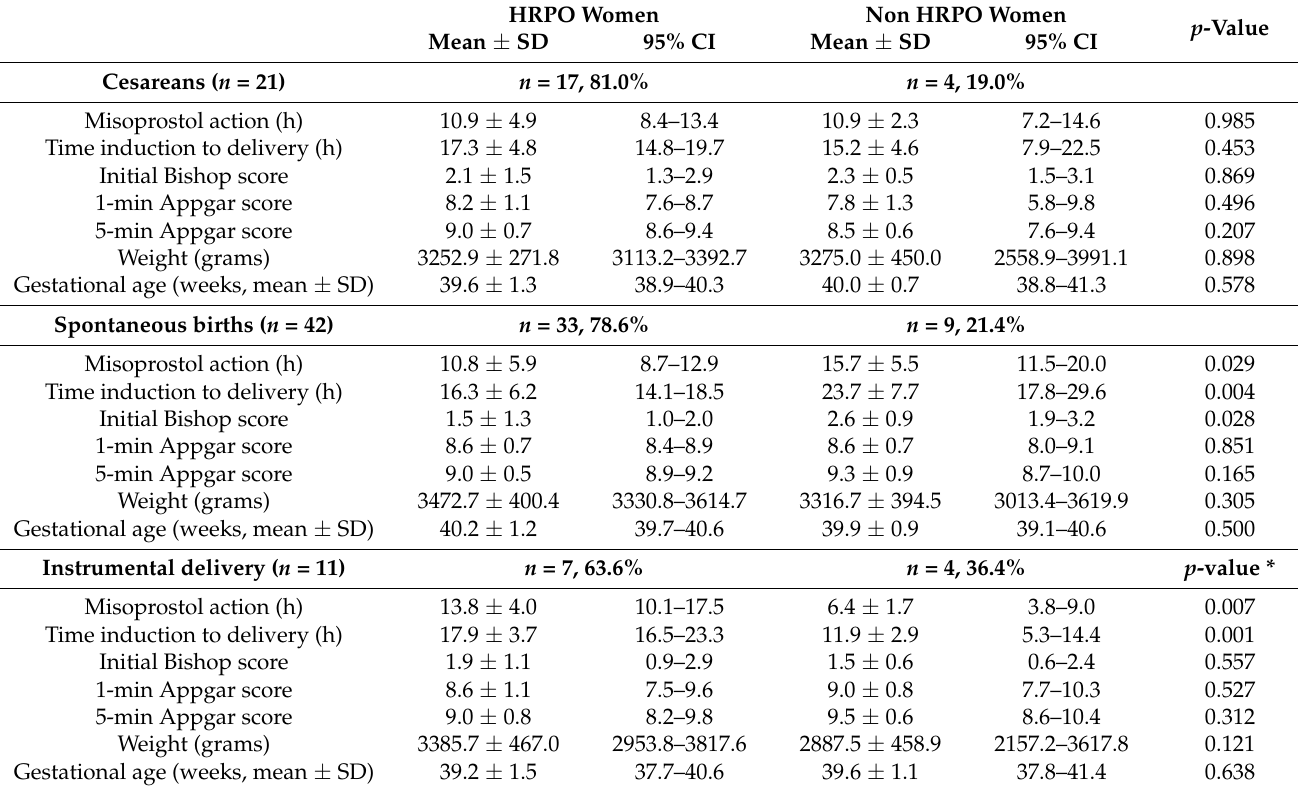
Table 5. Outcomes of the MVI IOL in the studied groups (non-HRPO and HRPO) by type of